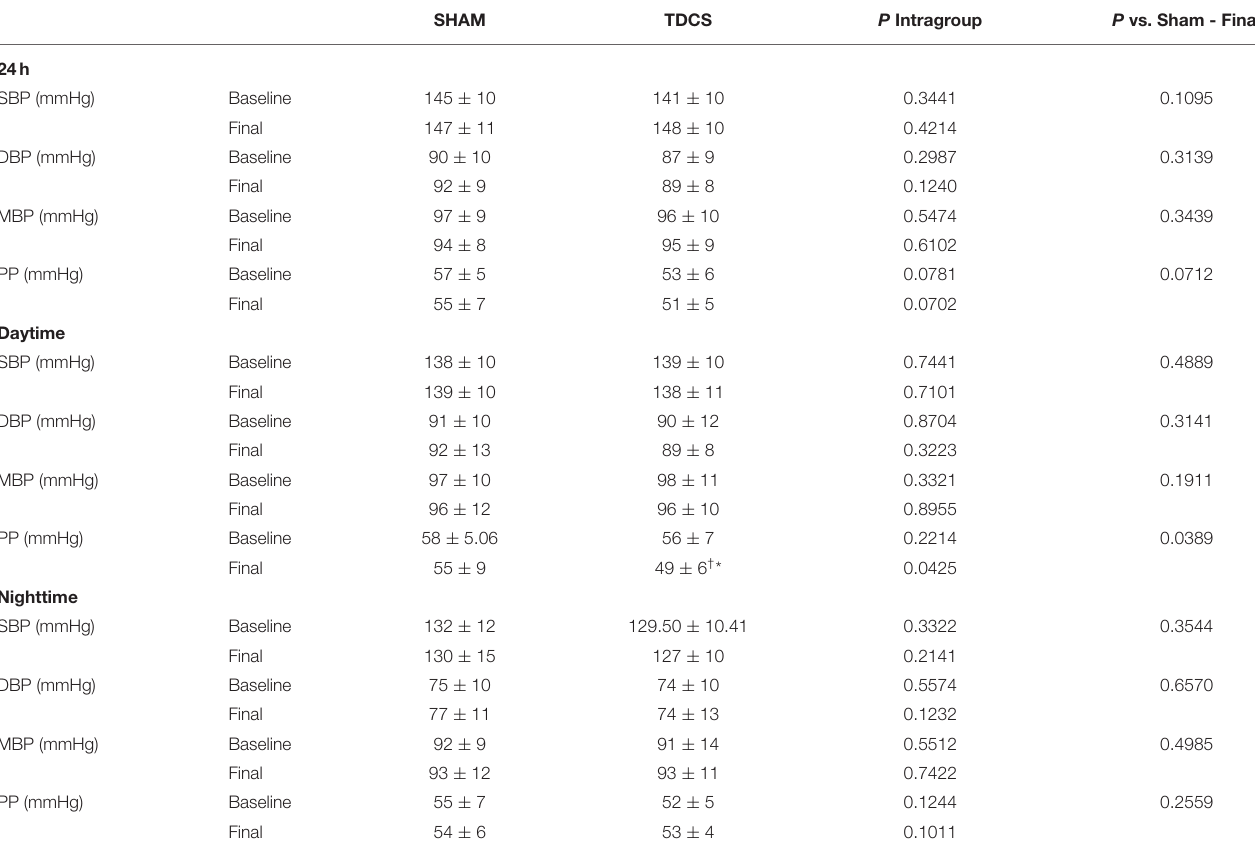
TABLE 5 | Short-term intervention (10 sessions): 24-hs-ambulatory blood pressure measurements (ABPM) in resistant hypertensive patients at baseline and after 10 sessions of SHAM or tDCS. SHAM